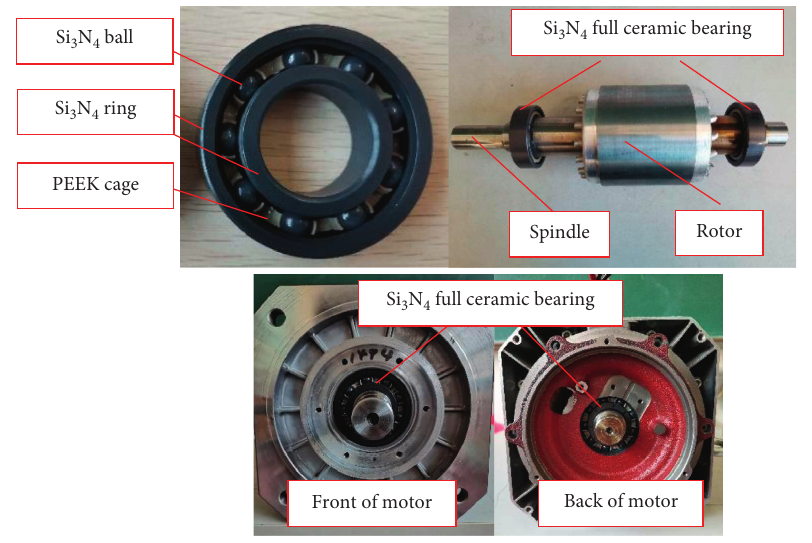
Figure 3: Assembly of the spindle motor.